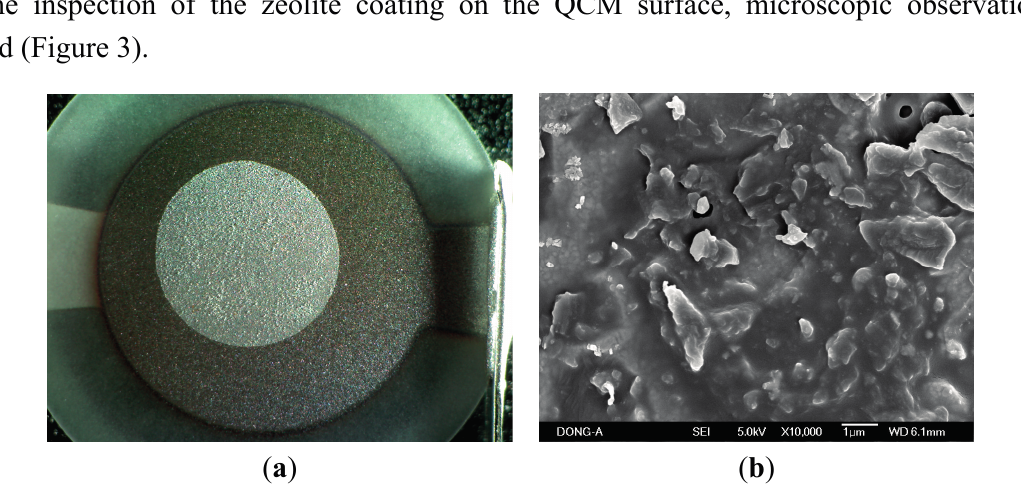
Figure 3. Photographs of the QCM surface by ( a ) Optical microscope; ( b ) Scanning electron microscope (×10,000 times). In image (a), the outer circle with connection path on the right-hand side is the silver electrode, and white inner circle demonstrates the PMMA coating. The center of the QCM is more sensitive than the outer